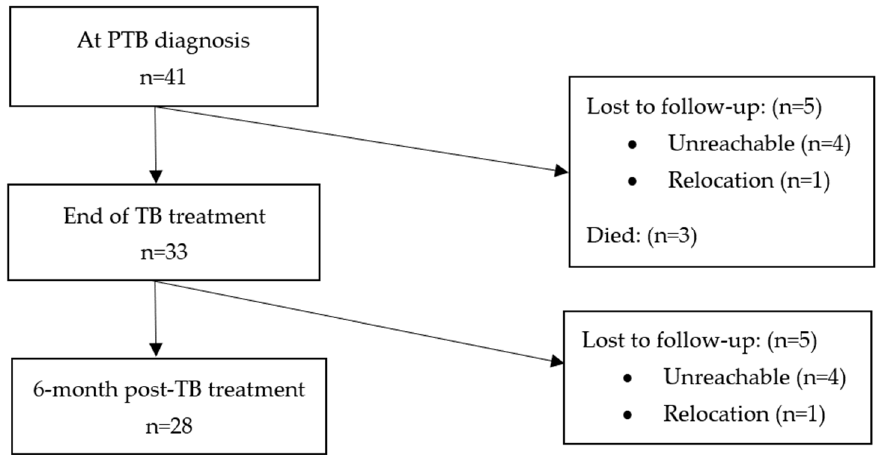
Figure 1. Overview of 41 patients enrolled.